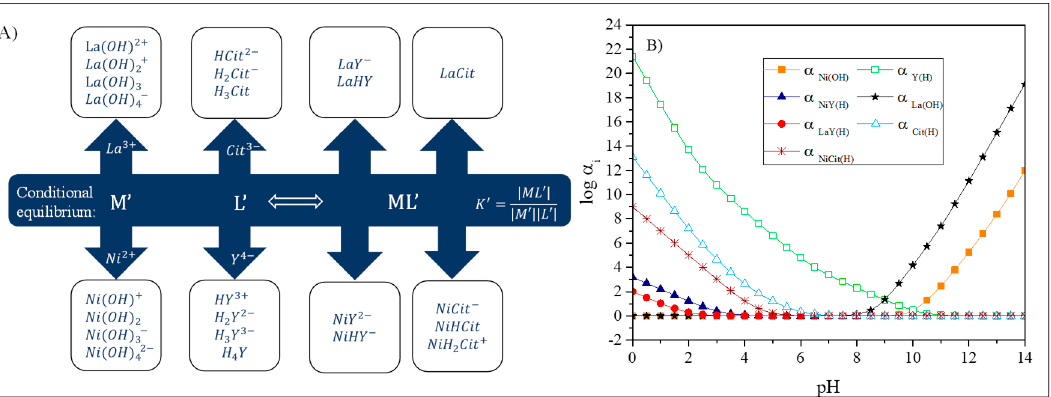
Figure 1. pH dependence of the coefficient of parasitic reactions ( A ) and description of the conditional equilibrium and parasitic reactions ( B ).